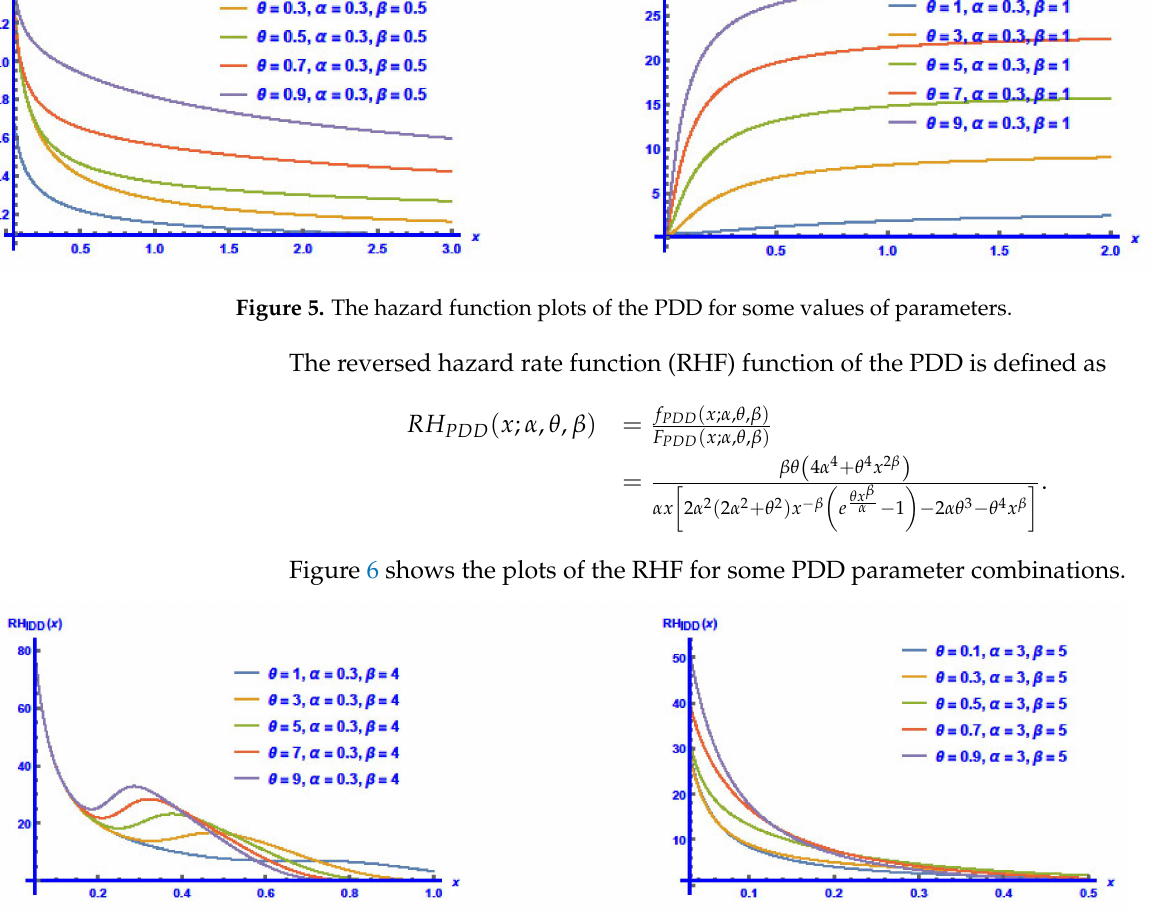
Figure 6. The RHF plots of PDD for different values of parameters.